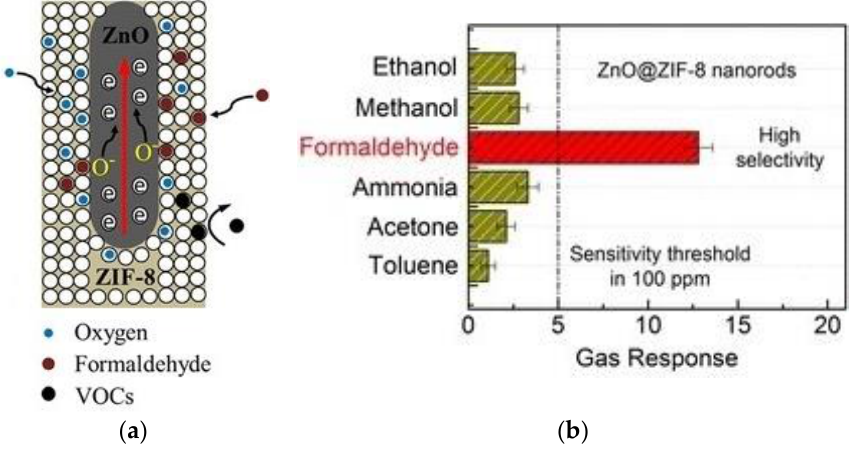
Figure 20. ( a ) Schematic illustration of the ZnO@ZIF-8 nanorod sensor with selectivity for different VOCs molecule; ( b ) gas selectivity to 100 ppm of different VOCs at working temperature of 300 °C [16].